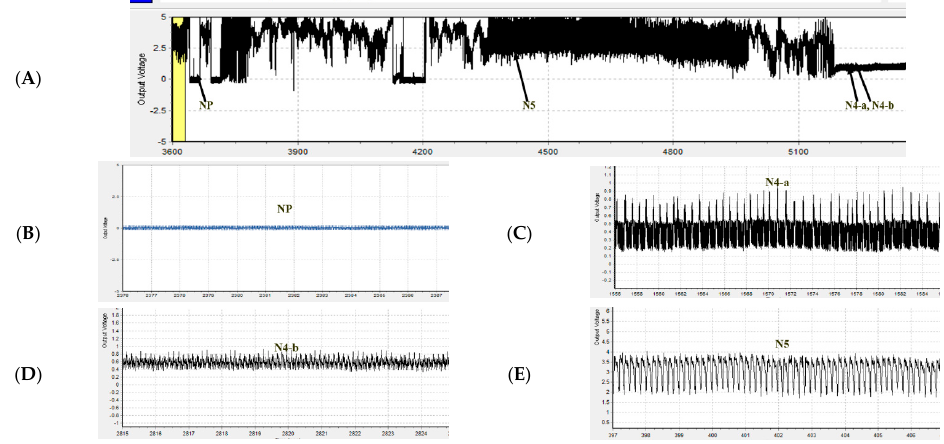
Figure 1. EPG waveforms of Nilaparvata lugens and S. furcifera adults. ( A ) Overall typical view for one hour and a half; ( B ) NP: nonpenetration; ( C ) N4-a: intracellular activity in the phloem region, which is necessary just prior to the ingestion of phloem sap; ( D ) N4-b: phloem sap ingestion; ( E ) N5: stylet activity in the xylem region.